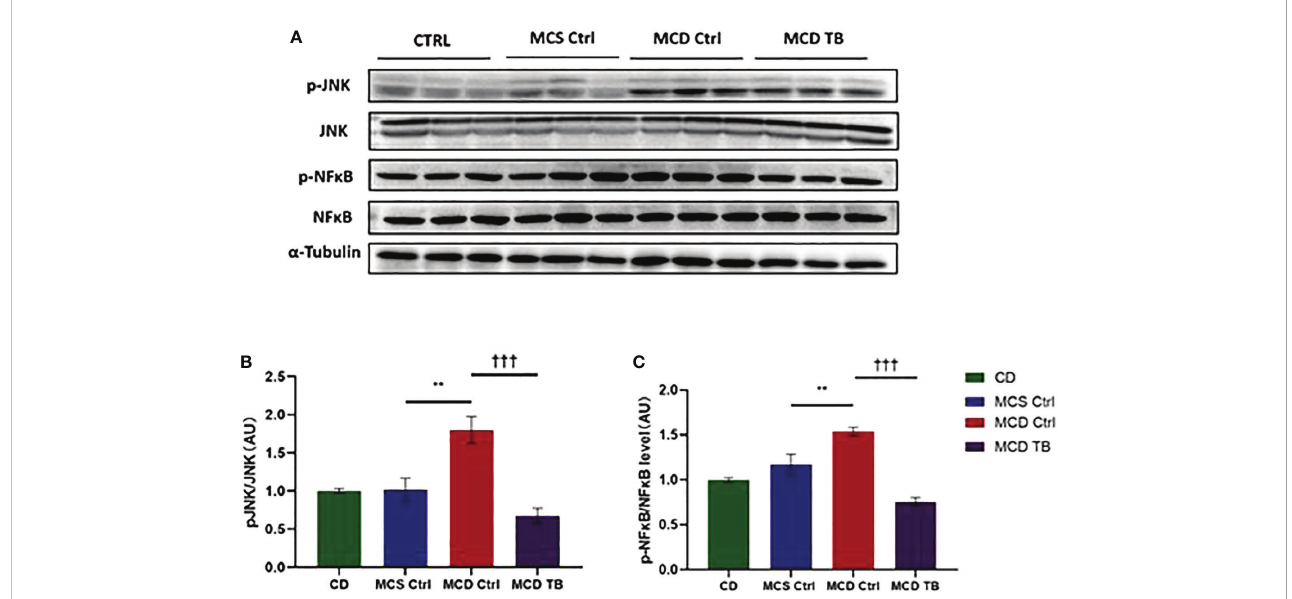
FIGURE 3 Theabrownin reduces liver pro-in fl ammatory response. (A) The phosphorylation and protein levels of NF k B p65 and JNK. (B) Quanti fi cation of JNK phosphorylation. (C) Quanti fi cation of NF k B p65 phosphorylation. AU, arbitrary units. n=5-11 mice per group. The data are mean ± s.e. (error bars).